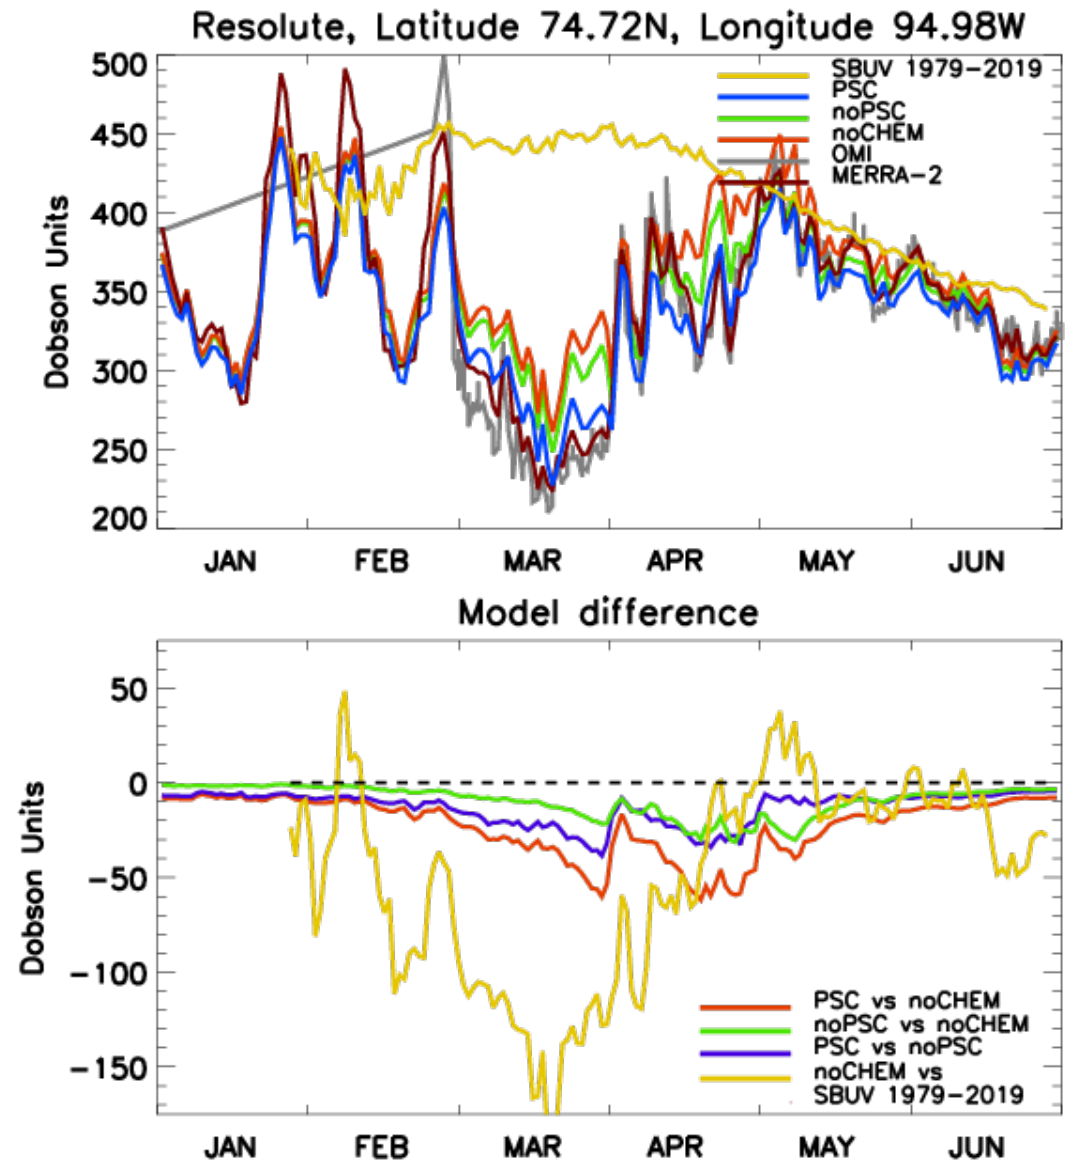
Figure 9. Column Ozone variability at Resolute Station for the first half of 2020 ( top ): SBUV mean over 1979–2019 (yellow), OMI data (gray), CTM basic scenario (PSC) (blue), CTM scenario without PSC processes included (noPSCaer) (green), CTM scenario with no chemical ozone destruction included (noCHEMall) (red); and column ozone difference between CTM simulation for several scenarios ( bottom ): noCHEMall and SBUV 1979–2019 averages (yellow), PSC and noCHEMall (red), and PSC and noPSCaer (blue).